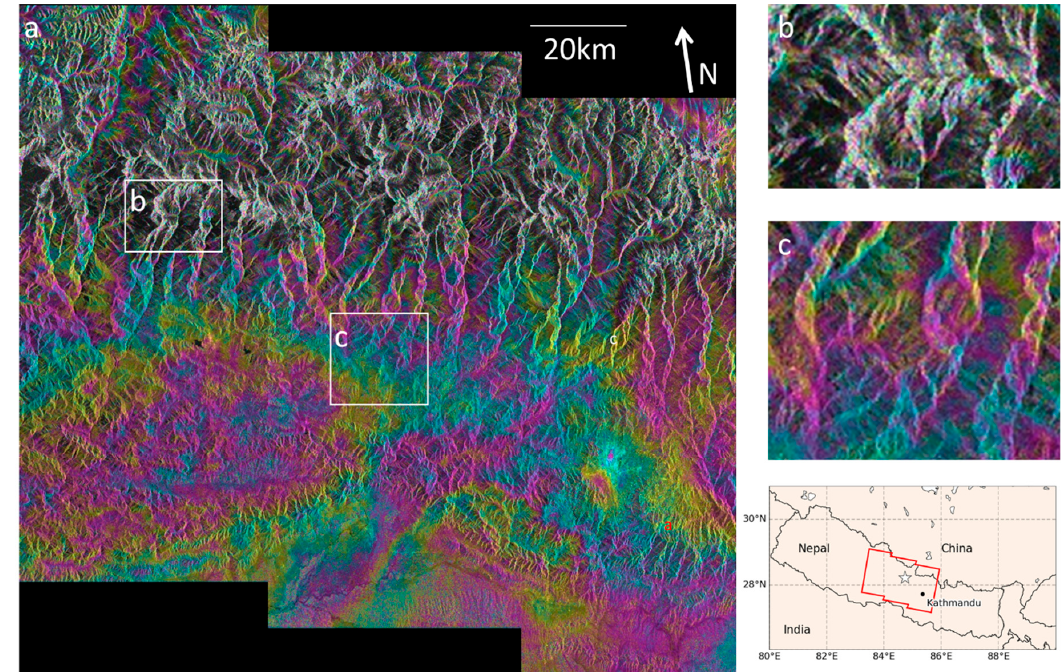
Figure 3. ( a ) Sentinel-1 interferogram produced using LiCSAR [33] for a pre-event SAR image pair acquired on 24 March and 17 April 2015. Each band of colour shows a phase change between image acquisitions equal to 2.8 cm. Background intensity shows the amplitude of the image acquired on 17 April. ( b ) An example of an area where many pixels are incoherent. In this case, neighbouring pixels do not have a similar phase change and so do not sum constructively, resulting in a low boxcar estimation of coherence. ( c ) An example of an area of high coherence. Neighbouring pixels have similar phase change so sum constructively, resulting in a high estimation of